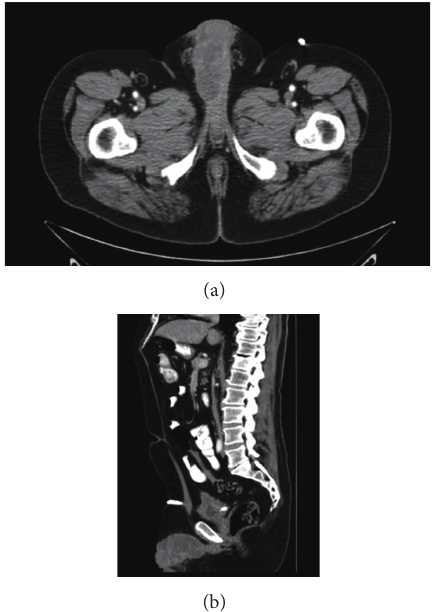
Figure 1: CT scan of abdomen and Pelvis with contrast showing the primary tumor. (a) Transverse view; (b) sagittal view.